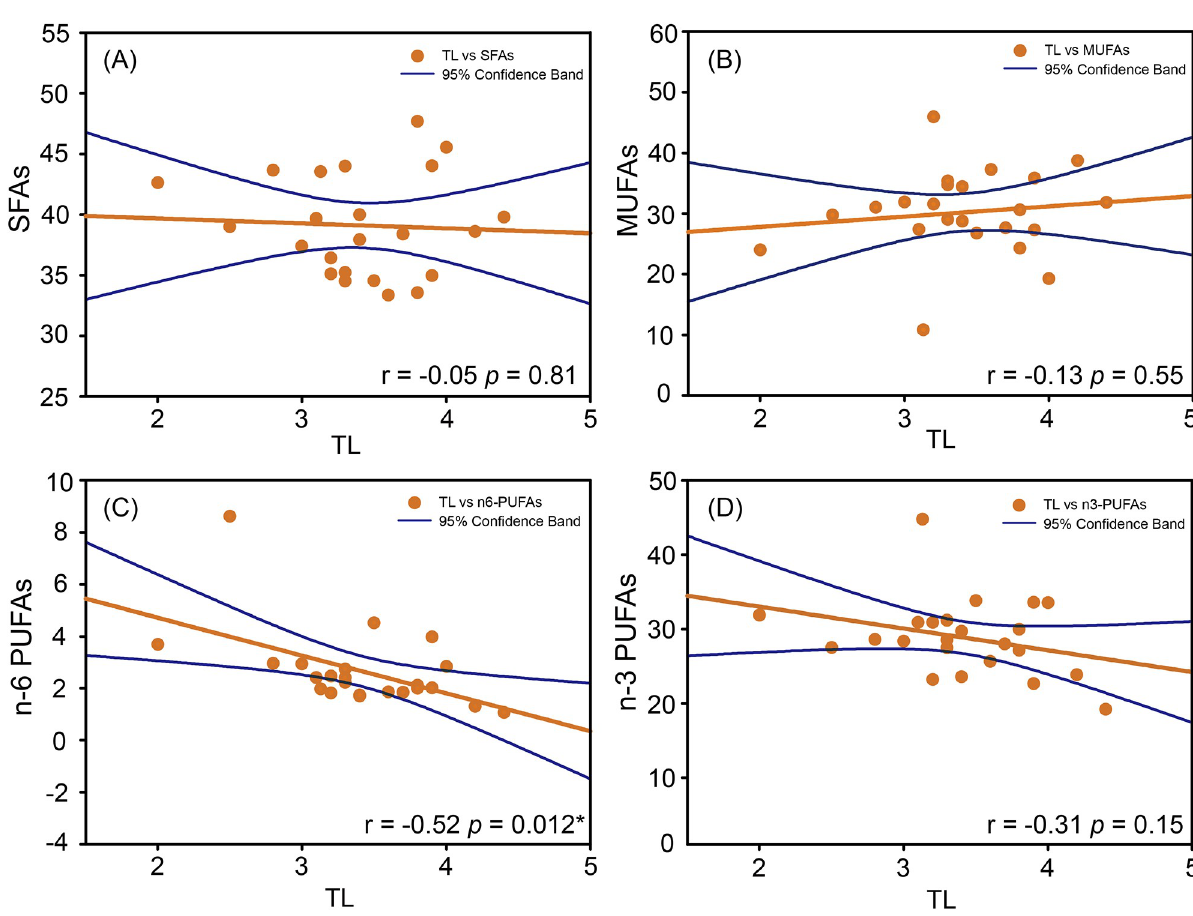
Fig 2. Relationships between trophic levels (TL) and saturated fatty acids (SFAs), monounsaturated fatty acids (MUFAs), n- 6 PUFAs and n- 3 PUFAs of the marine fish species from the PRE, China.